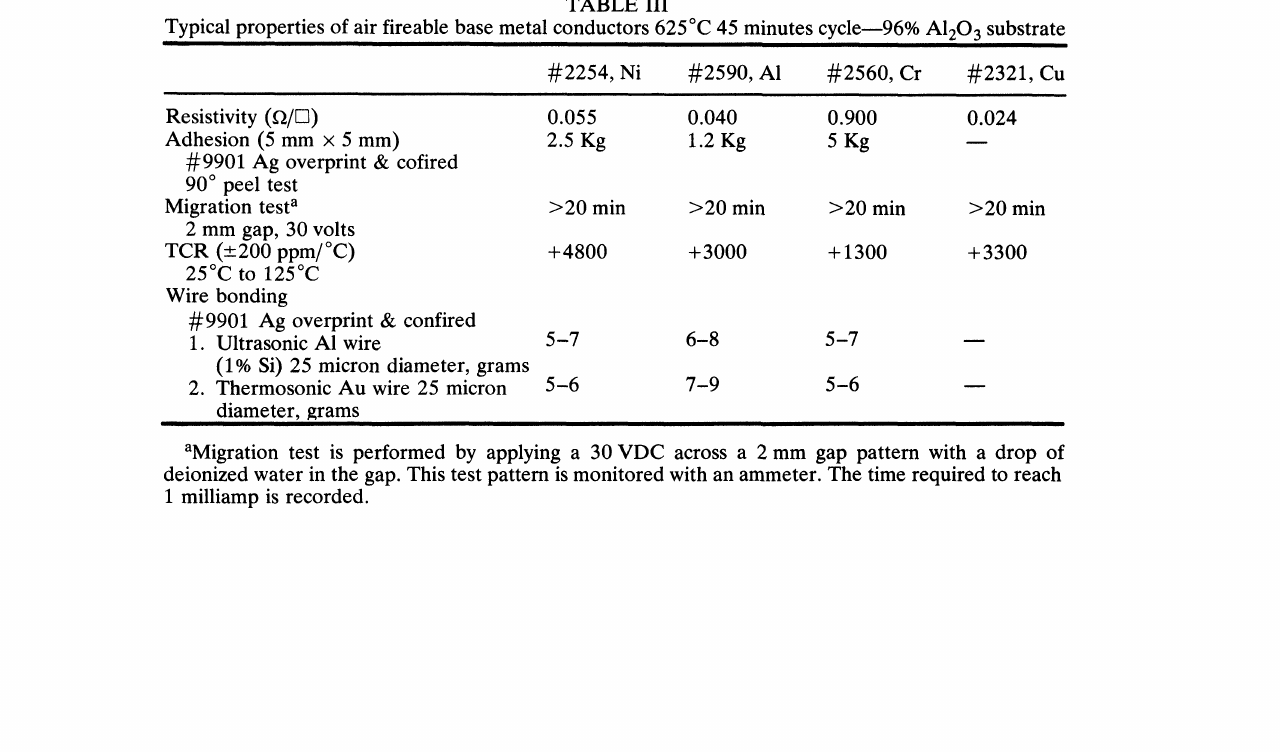
FIGURE 4 Defroster test